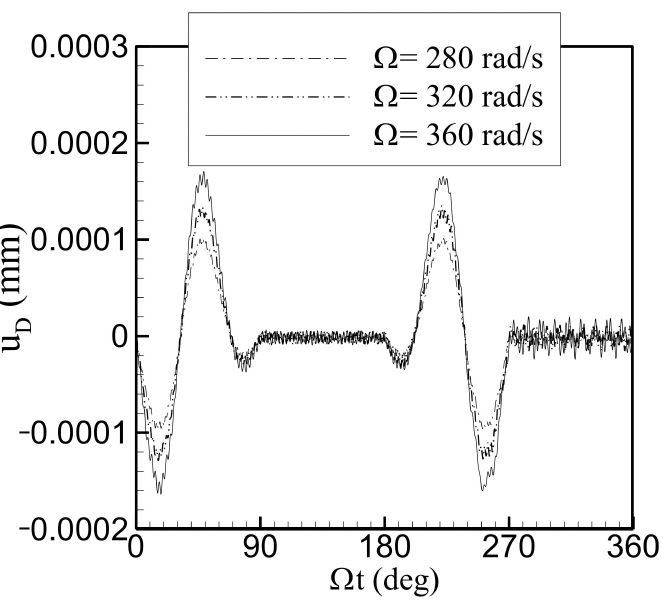
Figure 7. The time responses of the follower output node D in the axial direction at three cam speeds: 280, 320, and 360